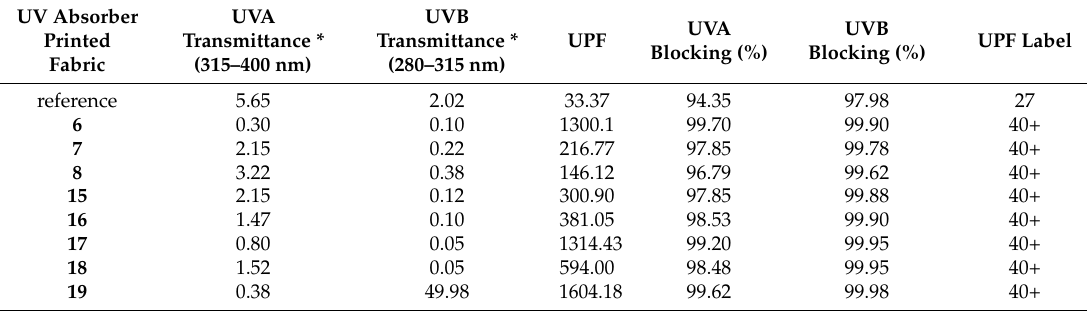
Table 3. UV protective features of absorbers.